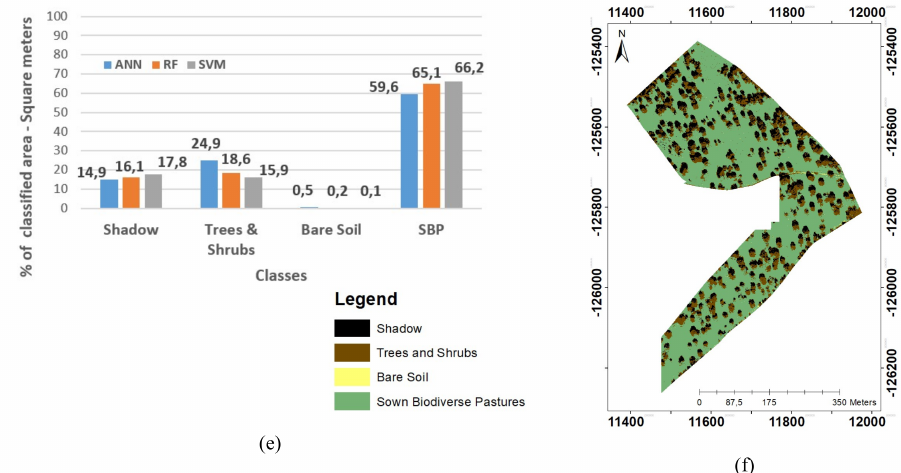
Figure 5. Relative distribution of land classes in each farm ( a —farm 1, c —farm 2 and e —farm 3) using single epoch classification with Artificial Neural Networks (ANN), Random Forest (RF) and Support Vector Machine (SVM) algorithms, and respective spatial distribution within each farm for the case of the RF classifier ( b —farm 1, d —farm 2 and f —farm 3). SBP—Sown Biodiverse Pastures.